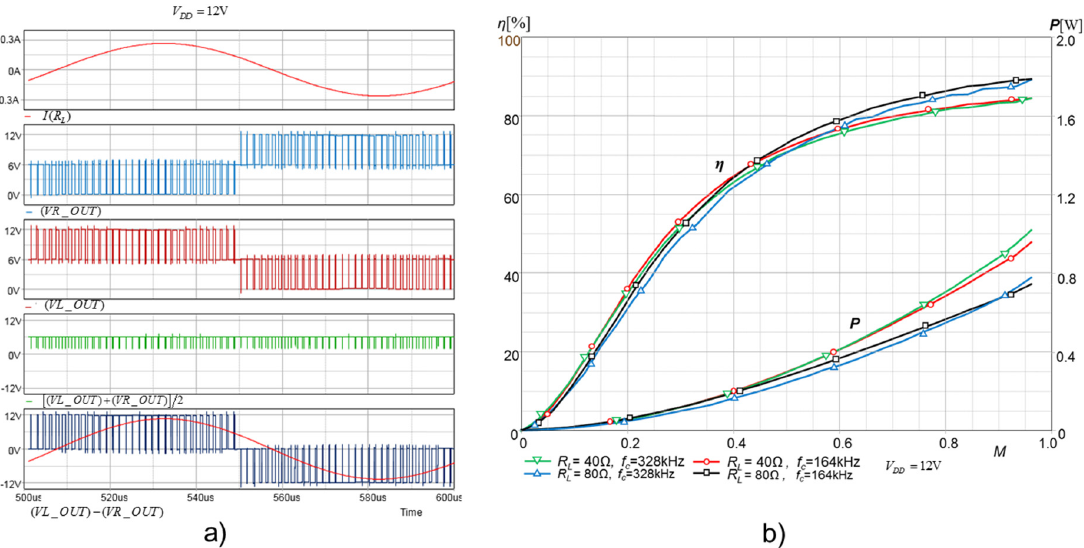
Figure 11. SPICE simulations of the low-power Class-BD amplifier with constant voltage at the CM output (in Figure 4a): ( a ) load current and output voltages in DM and CM modes; ( b ) output power and efficiency versus modulation index M.